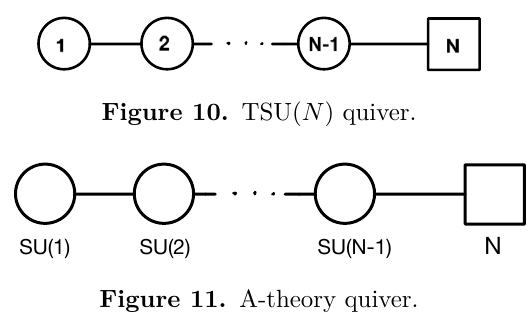
Figure 11. A-theory quiver.